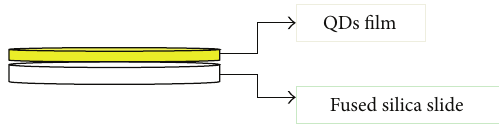
Figure 1: Structure of monolayer sample.